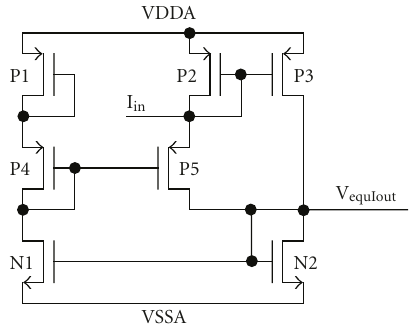
Figure 8: Circuit for computing the absolute value of a current.